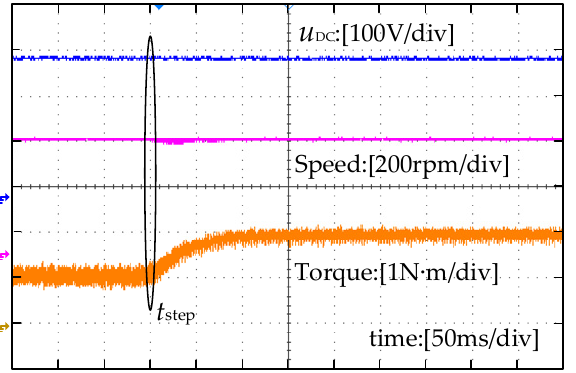
Figure 12. Dynamic experimental waveforms of a traditional motor driver with load-up from 1 to 1.5 Nm.